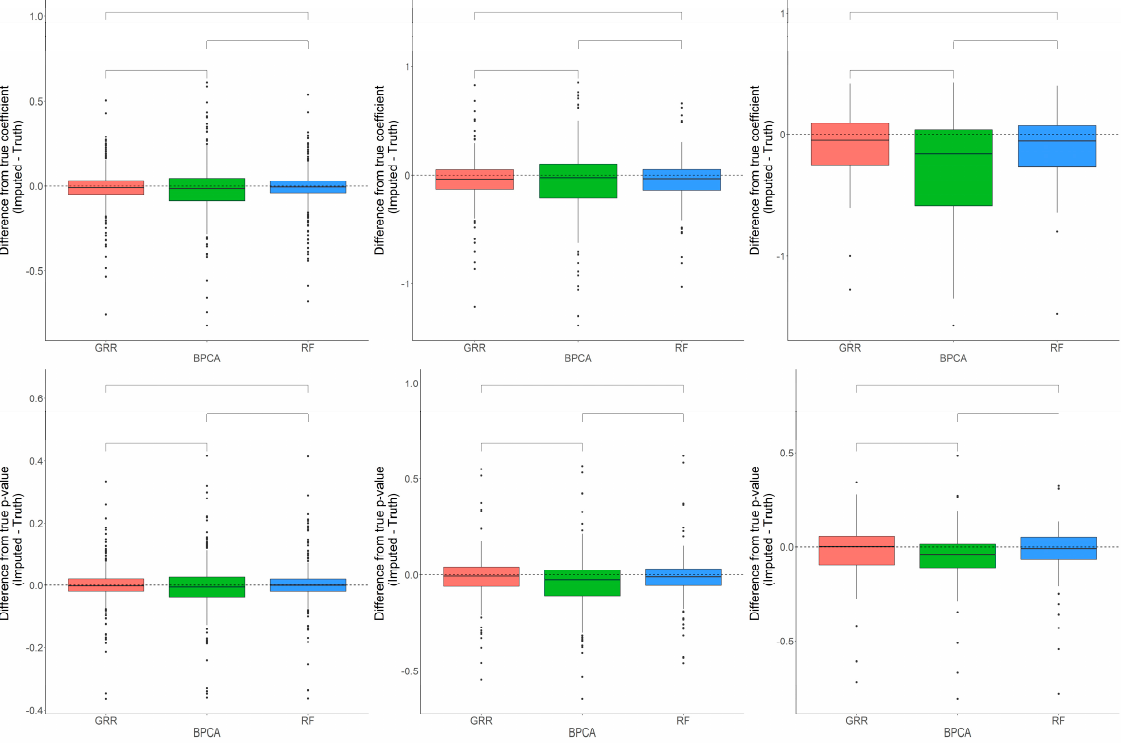
Figure 7. Evaluations of regression coefficient and regression p -value accuracy. Methods are listed across the x-axis. The differences between the regression coefficients (or p -values) computed on the complete data and the imputed data are shown on the y-axis. The top row demonstrates differences in regression coefficients evaluated in the baboon liver samples for metabolites with <10%, 10–20%, and 20–30% missingness. The top row demonstrates differences in regression p -values evaluated in the baboon liver samples for metabolites with <10%, 10–20%, and 20–30% missingness. The center line represents the median. The lower and upper box limits represent the 25% and 75% quantiles, respectively. The whiskers extend to the largest observation within the box limit ± 1.5 × interquartile range. Black dots represent single iterations of evaluating differences that are outliers. The p -values are based on pairwise testing with the Wilcoxon Rank Sum test (* corresponds to p ≤ 0.05; ** corre- sponds to p ≤ 0.01; *** corresponds to p ≤ 0.001; **** corresponds to p ≤ 0.0001).